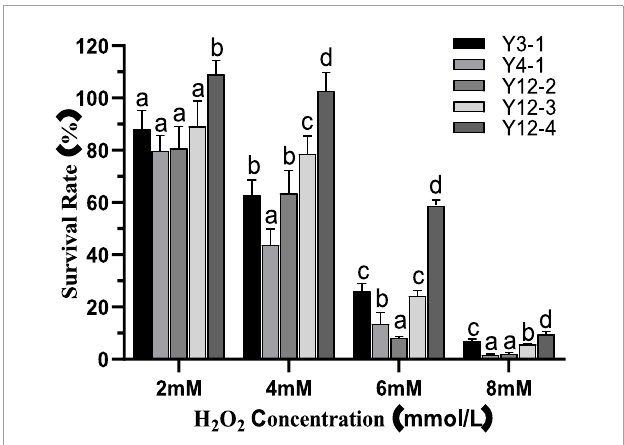
FIGURE1 Survival rate of yeast at different concentrations of H 2 O 2 . Different letters (a–d) indicated that there was significant difference in survival rate between different yeast groups at the same H 2 O 2 concentration ( p <